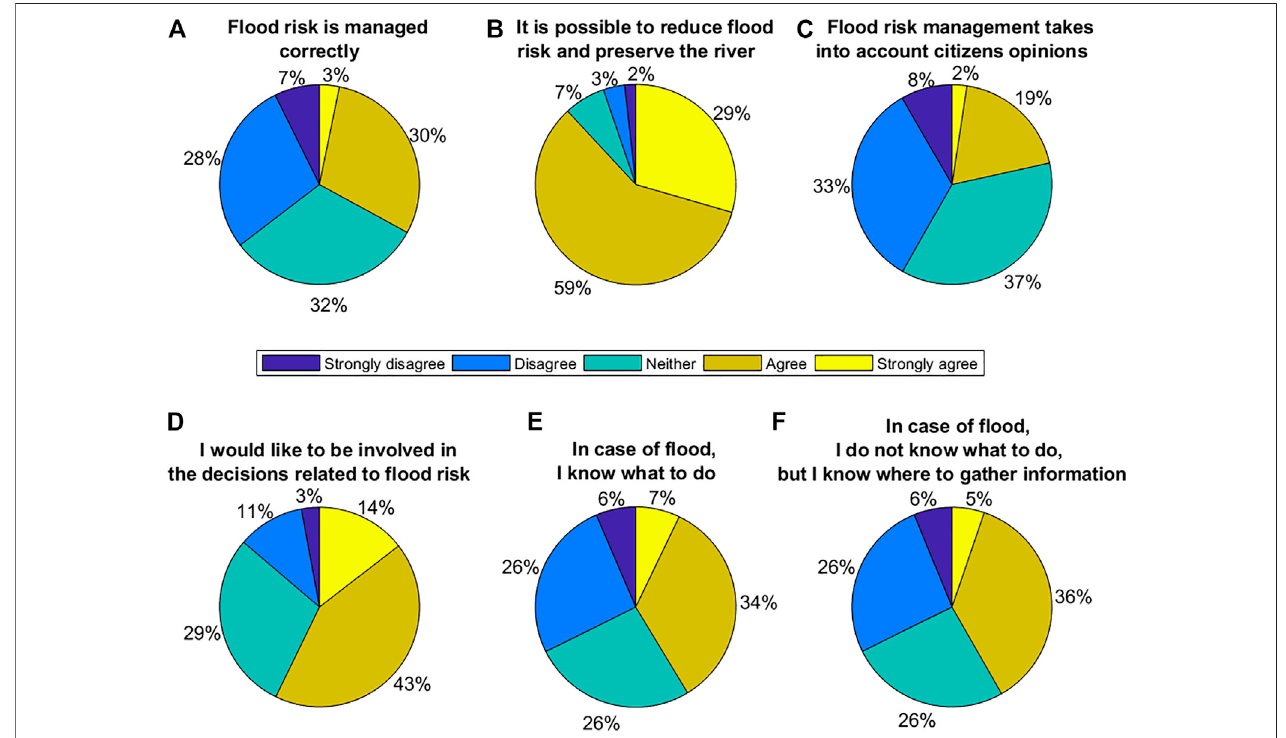
FIGURE 2 | Level of agreement for Q4 ( How much do you agree with the following statements on fl ood risk in the Tagliamento river basin? ).